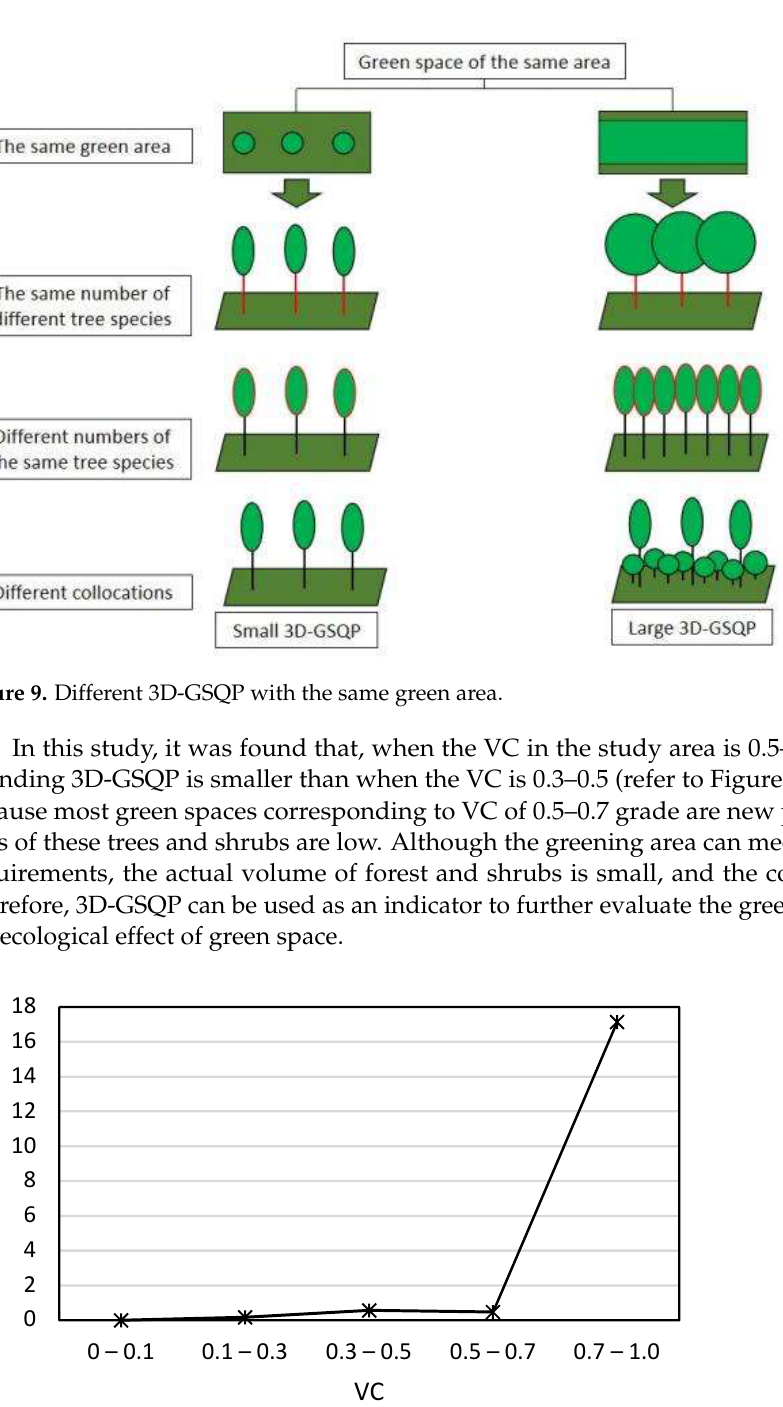
Figure 10. The relation graph between VC and 3D-GSQP.